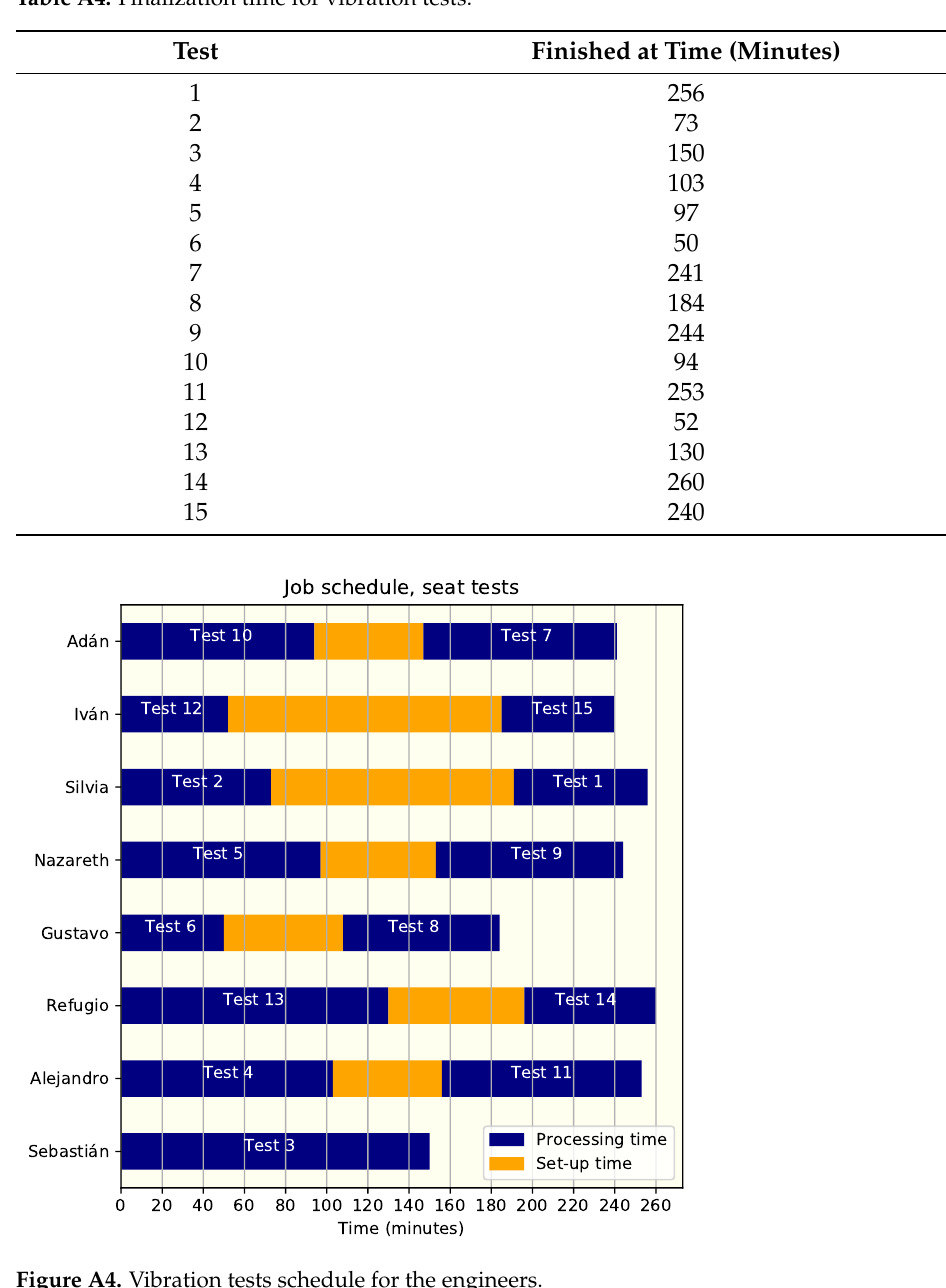
Table A4. Finalization time for vibration tests.